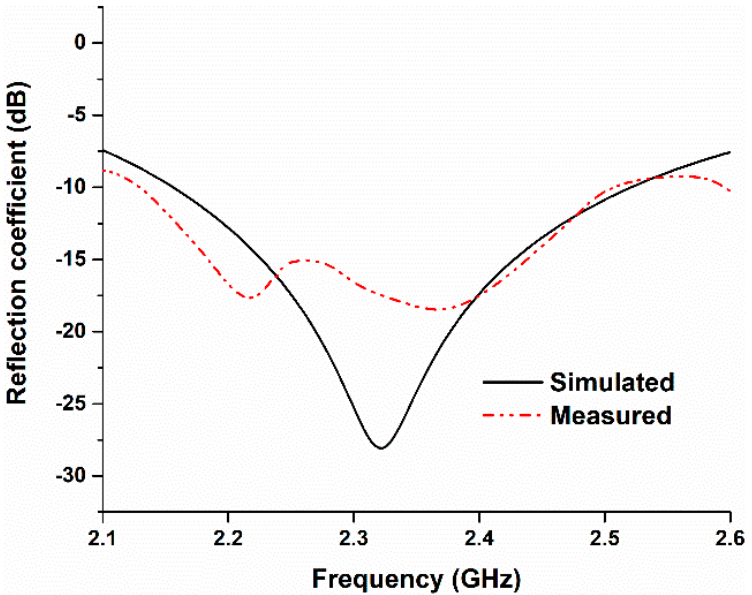
Figure 17. Reflection coefficients of the proposed antenna with the muscle phantom.